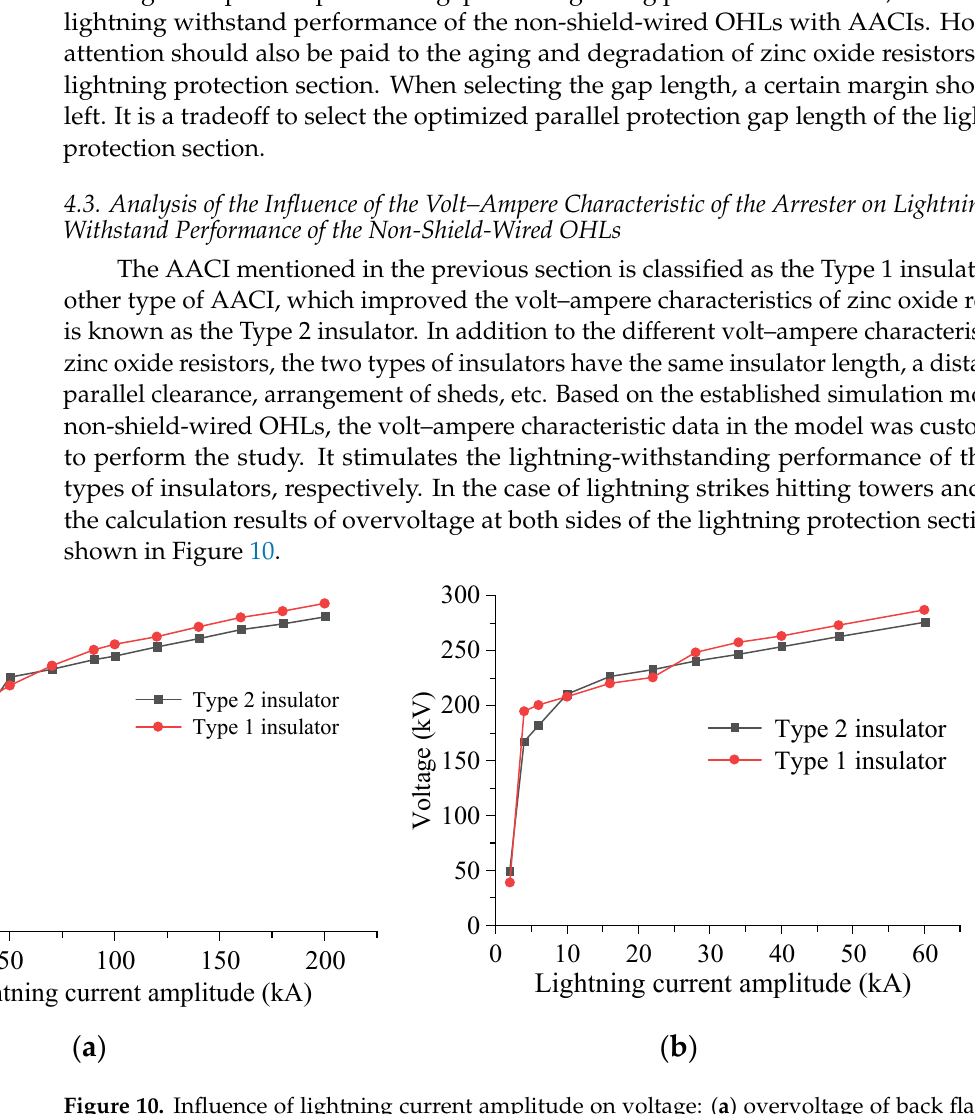
Table 6. Lightning trip rate under different earth resistance of Type2 insulator. Earth Resistance